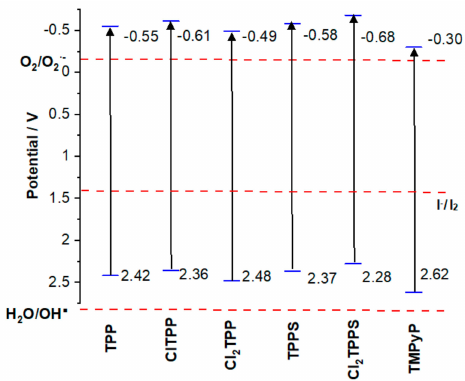
Figure 5. The comparison of the HOMO–LUMO level of porphyrins with water, oxygen, and iodine redox potential. The blue lines represent the potentials determined from the electrochemical measurements and the purple lines indicate values from the photoelectrochemical